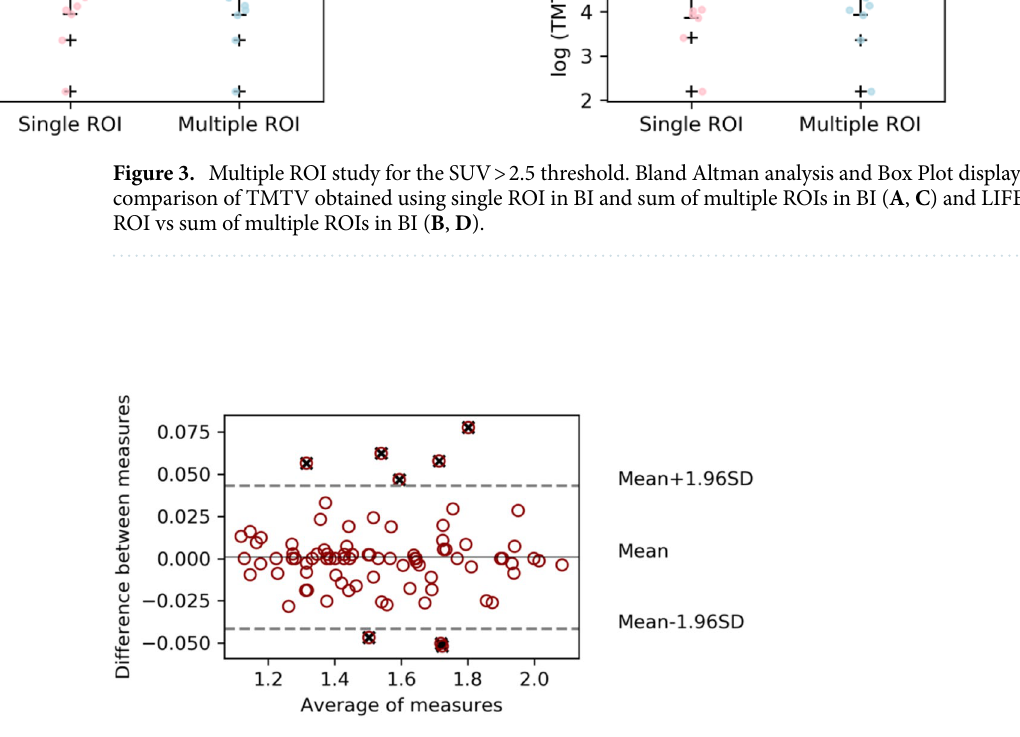
Figure 4. SUV mean comparison using both software applying 2.5 SUV threshold. Limits of agreement are also displayed, as well as outliers marked with a black